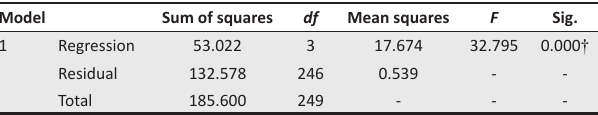
TABLE 6: ANOVA results for the model.